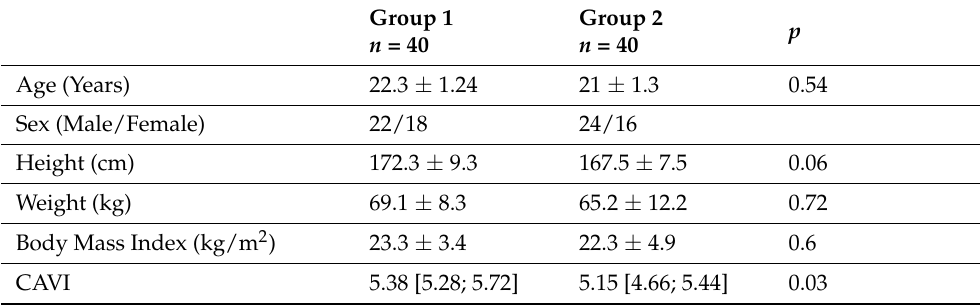
Table 1. The characteristics of the European and African young